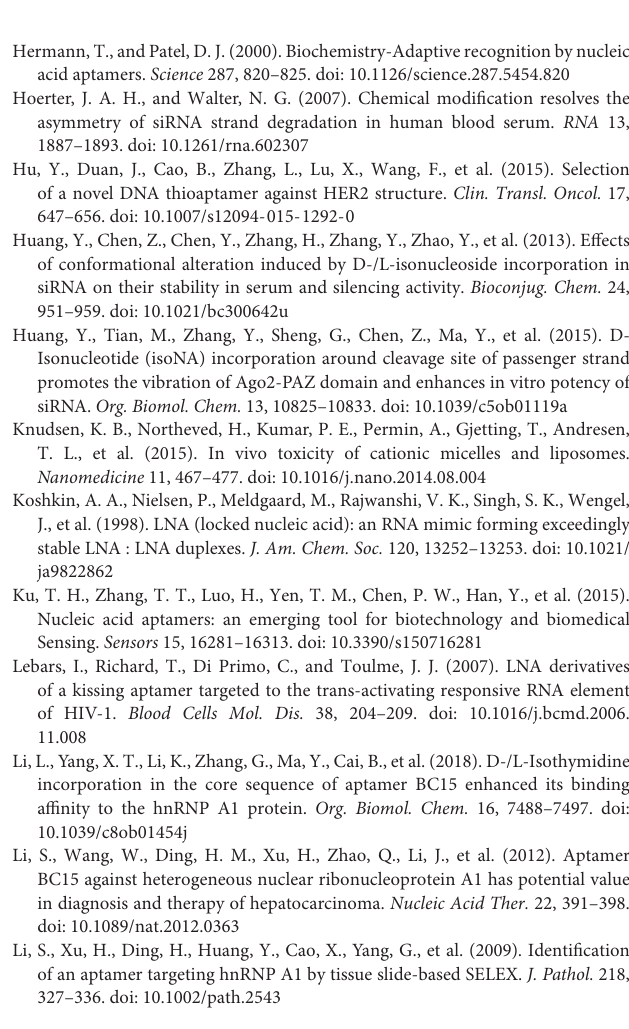
Supplementary Figure 1 | The antiproliferation activity of WW-24 encapsulated in different ratios of DNCA/CLD upon A375 (25 nM). Supplementary Figure 2-42 | The ESI-MS of 41 aptamers. Supplementary Figure 43-49 | The gel pattern of Figure 5A